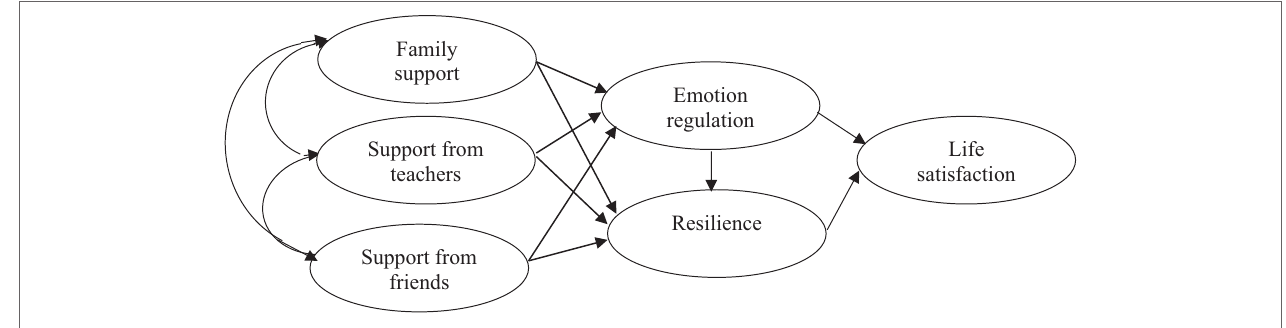
FIGURE 1 | Proposed theoretical